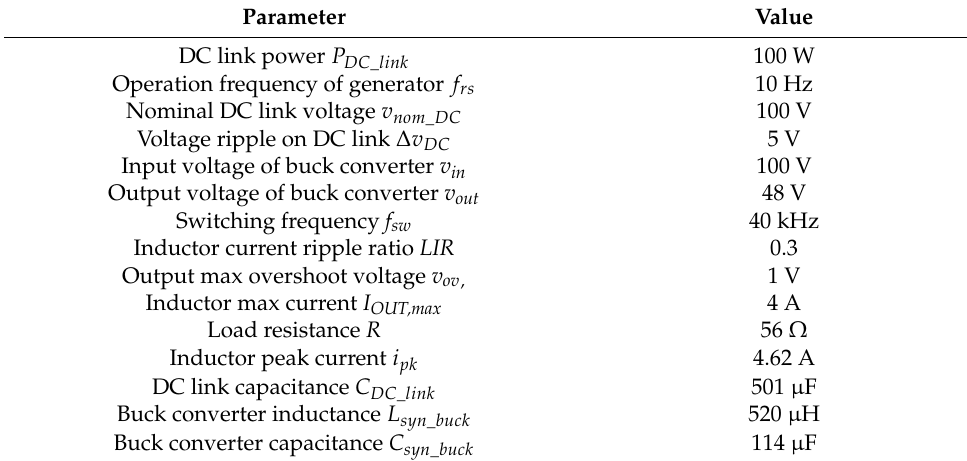
Table 1. Designed power converter